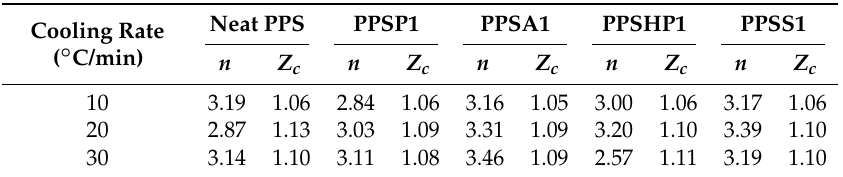
Figure 10. Avrami plots of ln [ − ln ( 1 − X t )] versus ln t for non-isothermal crystallization of the PPS/MWCNTs composites. ( a ) Neat PPS, ( b ) PPSP1, ( c ) PPSA1, ( d ) PPSHP1, and ( e ) PPSS1. Table 2. Non-isothermal kinetic parameters of the PPS/MWCNTs composites at different cooling rates using the modified Avrami equation.